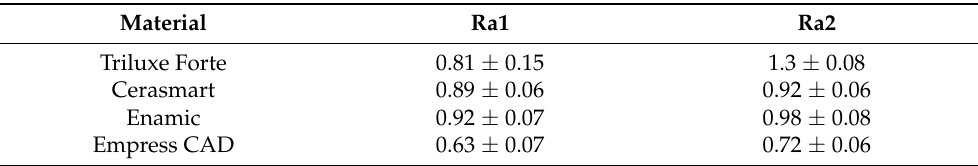
Table 4. Mean and standard deviations (SD) of surface roughness test ( µ m), before (Ra1) and after (Ra2) simulated gastric acid solution exposure.